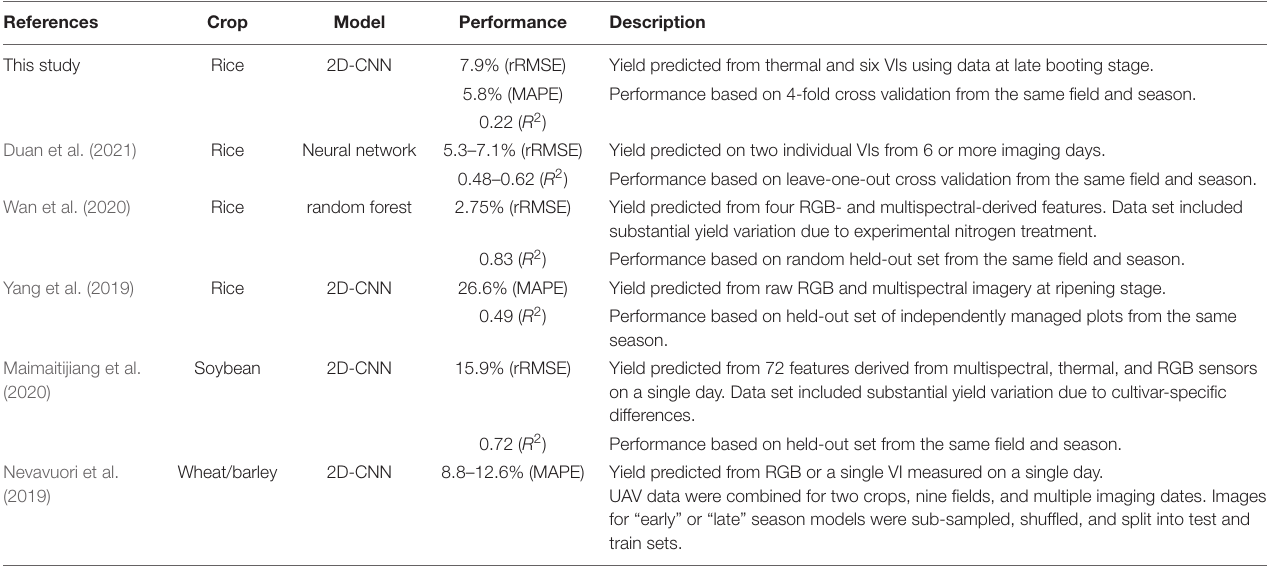
TABLE 5 | Model performance for comparable studies using UAV imagery for yield